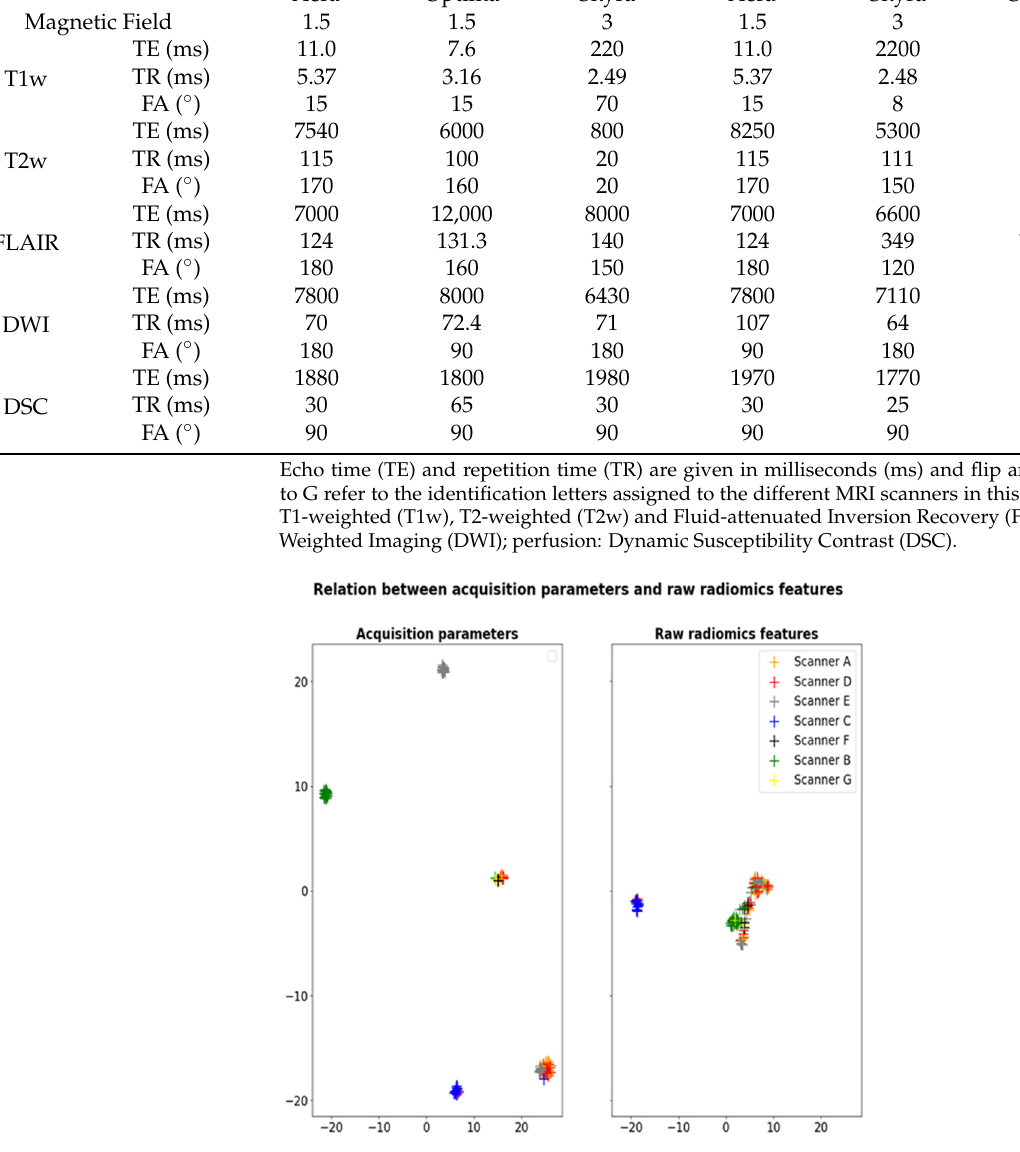
Figure 2. Dimensionality reduction of acquisition parameters TE, TR, flip angle, slice thickness and pixel spacing (left) and radiomics features extracted from the healthy ROIs in T1w images (right) with UMAP showing the sensitivity of radiomic features to the scanner